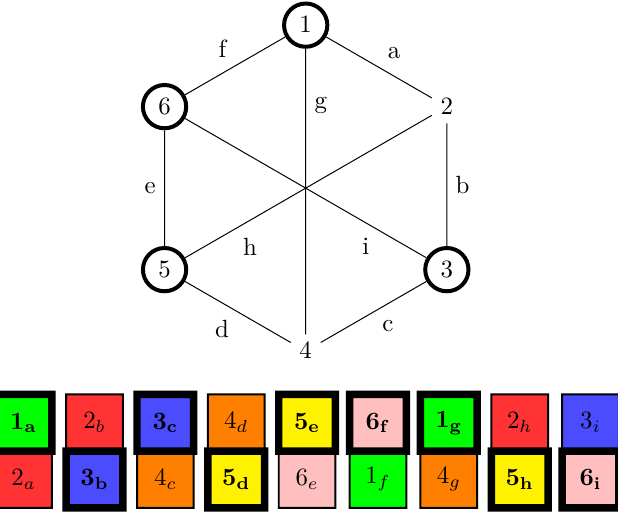
Figure 1 Illustration of the reduction from vertex cover. The big circled vertices correspond to a minimum size vertex cover of the graph. Below we show the instance of the robust representative selection problem corresponding to this graph. Each column corresponds to a partition 𝑇 𝑒 from which one of the two elements must be selected. The colors correspond to the regions 𝑃 𝑣 of the instance. The bold elements are an optimal solution corresponding to the shown vertex cover of the graph. Note that only elements in four regions (green, blue, yellow, pink), corresponding to the vertices 1,3,5,6 that are selected.